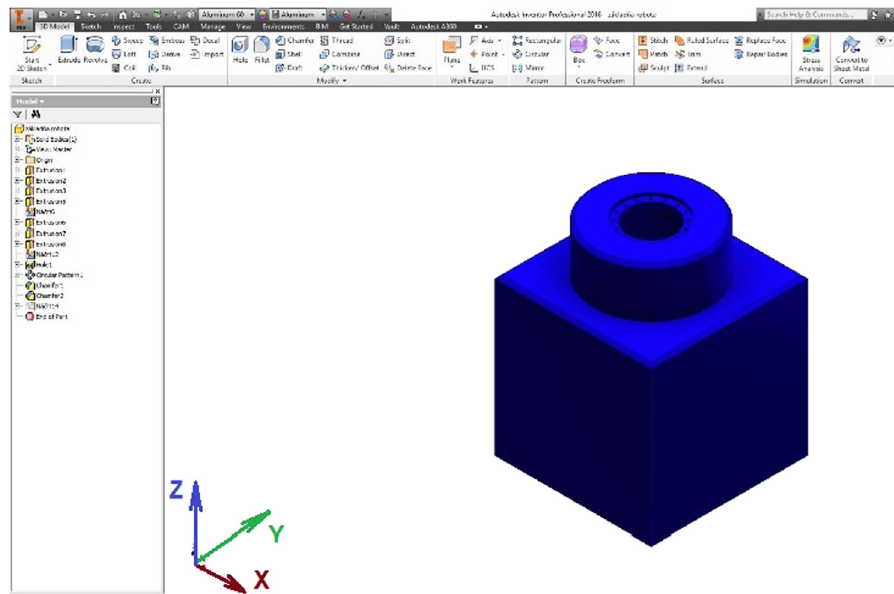
Figure 2: 3D model of a robot